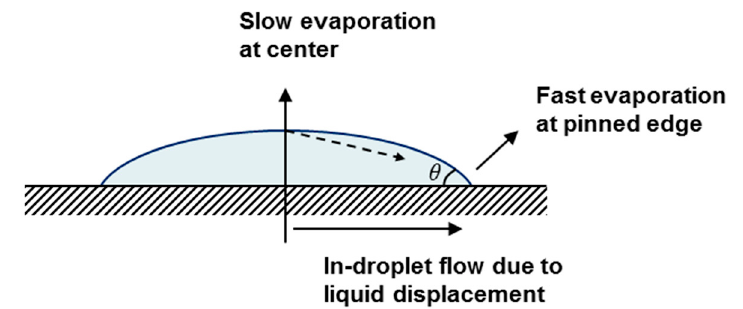
Figure 4. Flow towards droplet edges can result in the coffee ring effect (CRE). Dotted arrows show the direction of initial flow. Due to decreasing θ angle during evaporation, liquid displacement from center to edge occurs. On the other hand, if initial contact angle θ is sufficiently small and there is no surface tension gradient between center and edge, droplet can evaporate with minimal in-droplet flow towards edges.